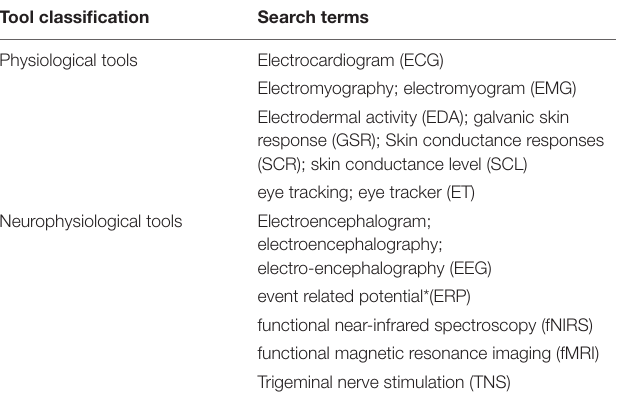
TABLE 1 | Search terms for neuroscience tools used in building construction.